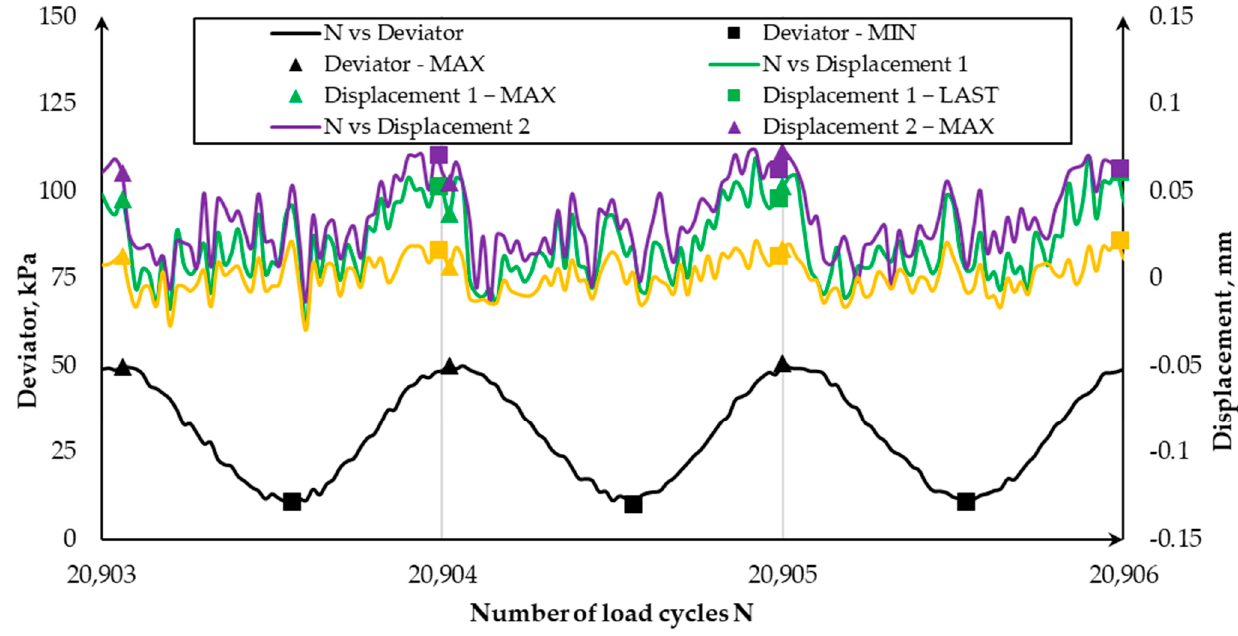
Figure 3. Fragment of results in graphs from a cyclic triaxial test of soil specimens.